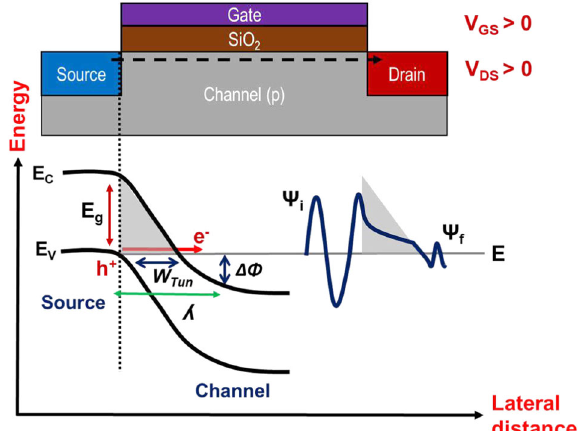
Fig. 2 Band to Band Tunneling in TFET. Schematic representation of BTBT in the tunneling junction of